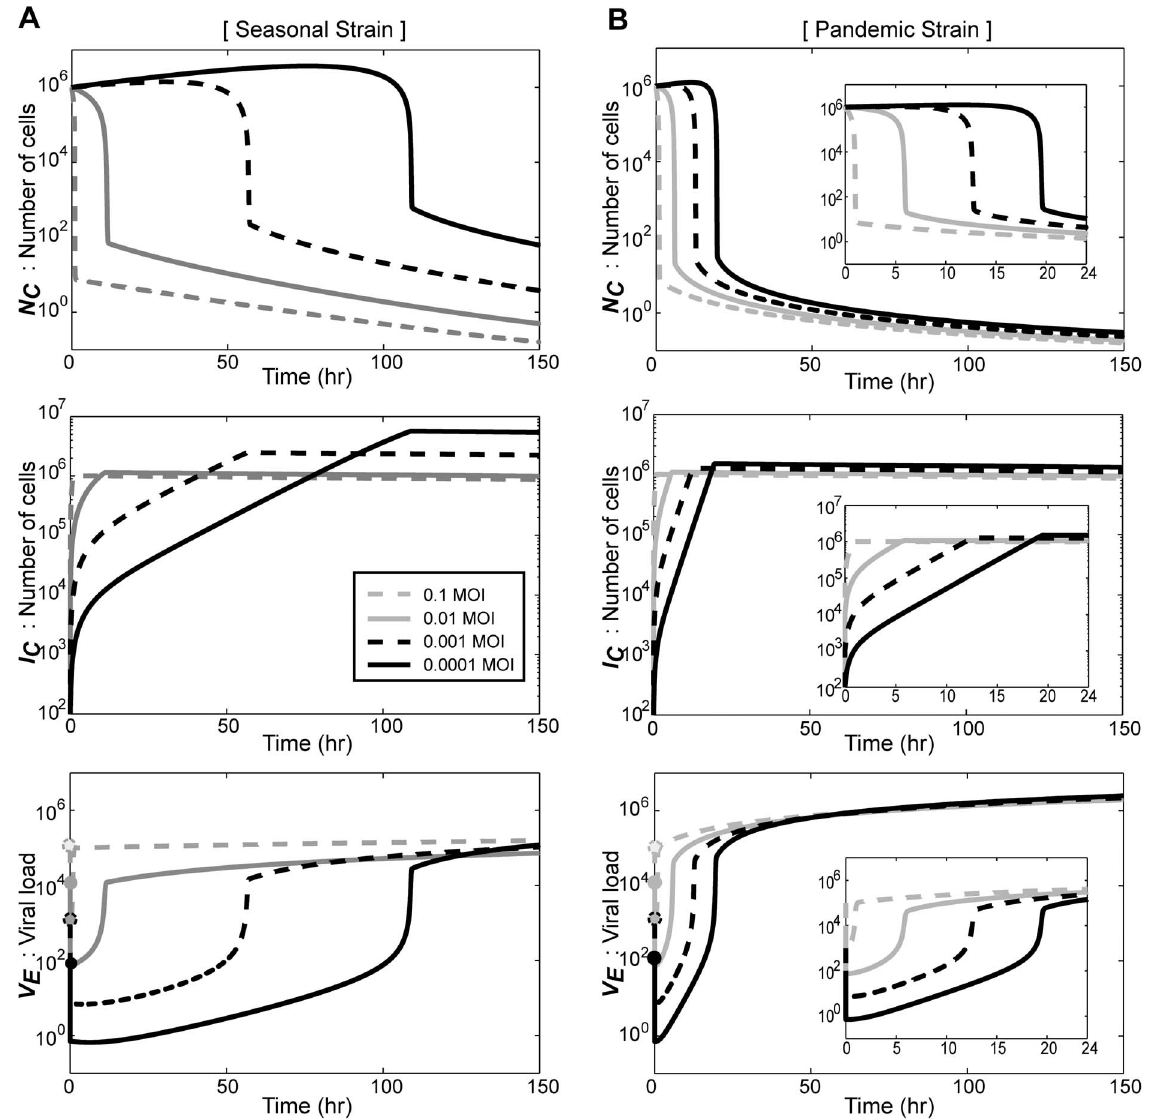
Figure 3. Dynamics of cells and virus with varying initial doses of the seasonal and pandemic strains. The dynamics of N C , I C , and V E were simulated for 150 hours after infection, with varying MOIs (0.0001–0.1) for infection with seasonal (A) and pandemic (B) influenza strains. The dynamics of each variable for the first 24 hours of infection are displayed within the small boxes.